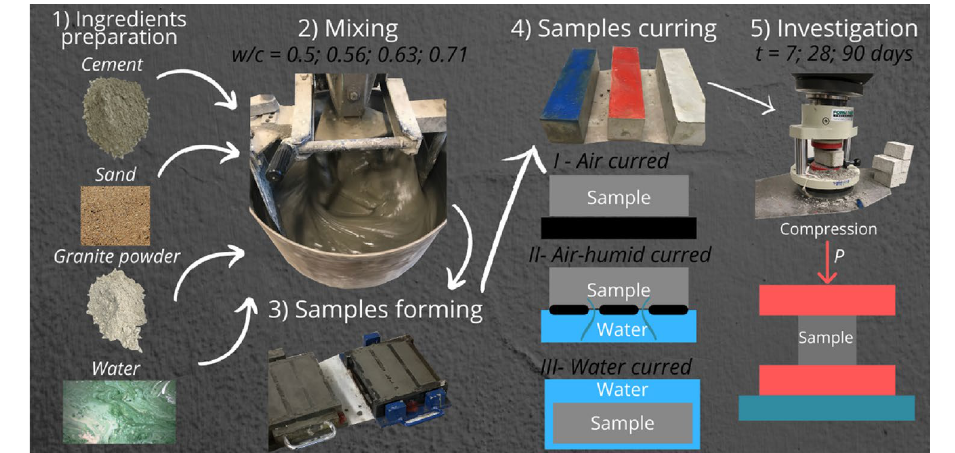
Figure 2. Production process of cement mortars with granite